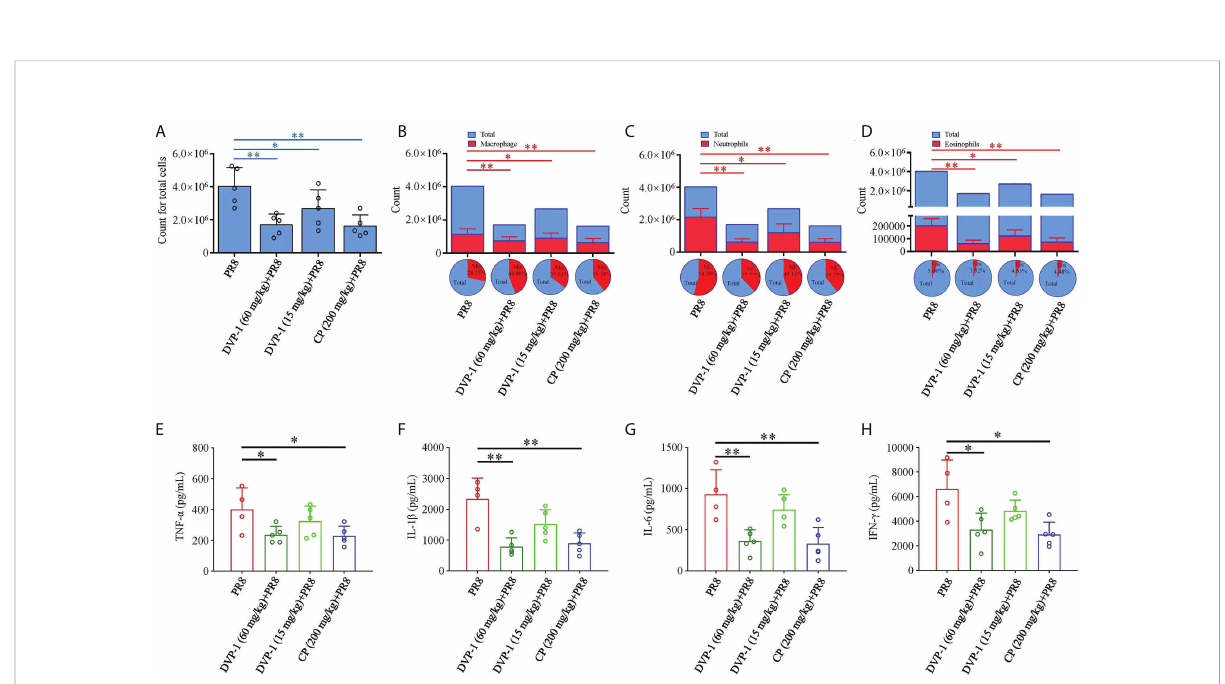
FIGURE 5 In fl ammatory cells and in fl ammatory factor levels in BALF. (A – D) , The number and proportion of total cells (A) , macrophages (B) , neutrophils (C) , and eosinophils (D) in BALF on the 6th day after infection of PR8. (E – H) The level of in fl ammatory factors in BALF by ELISA. *p < 0.05, **p <